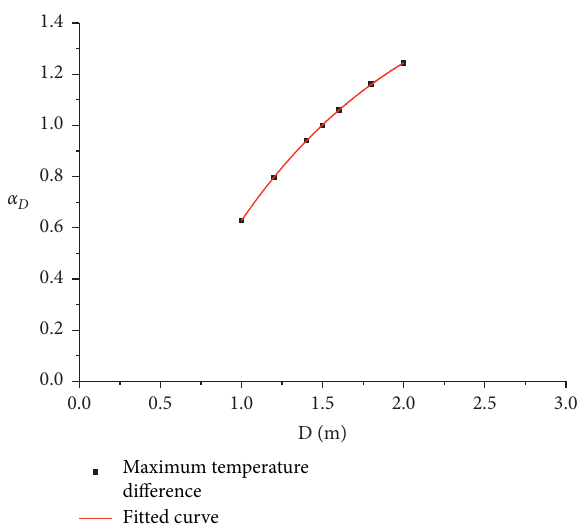
Figure 10: Fitted curve of parameter α diameters.